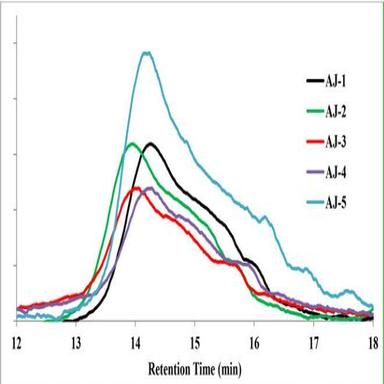
TGA thermograms of Chitosan/starch based PU.